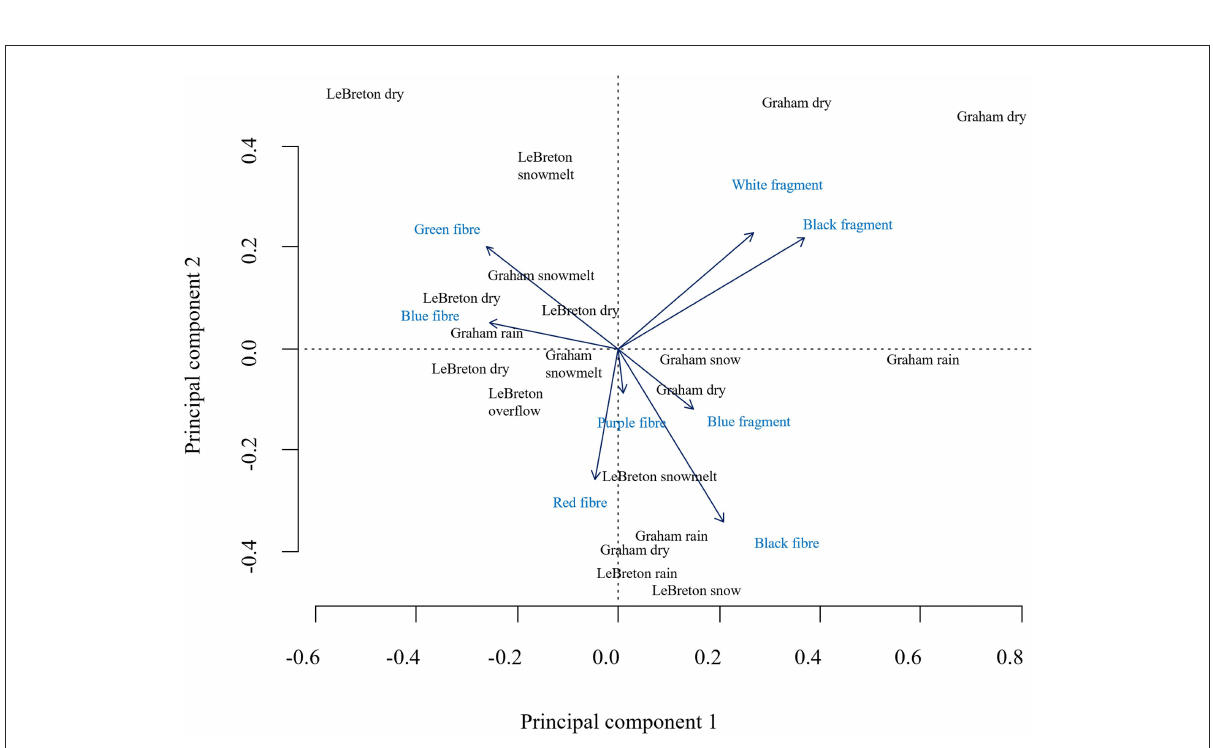
FIGURE5 A principal component analysis highlighting the change in fragment and fiber colors according to temporal